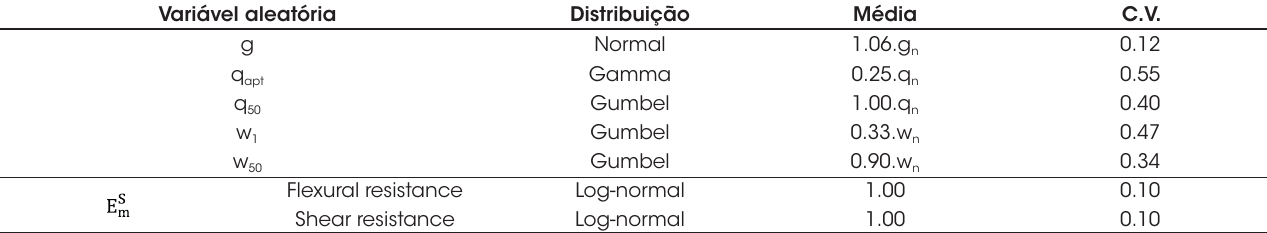
Load random variables